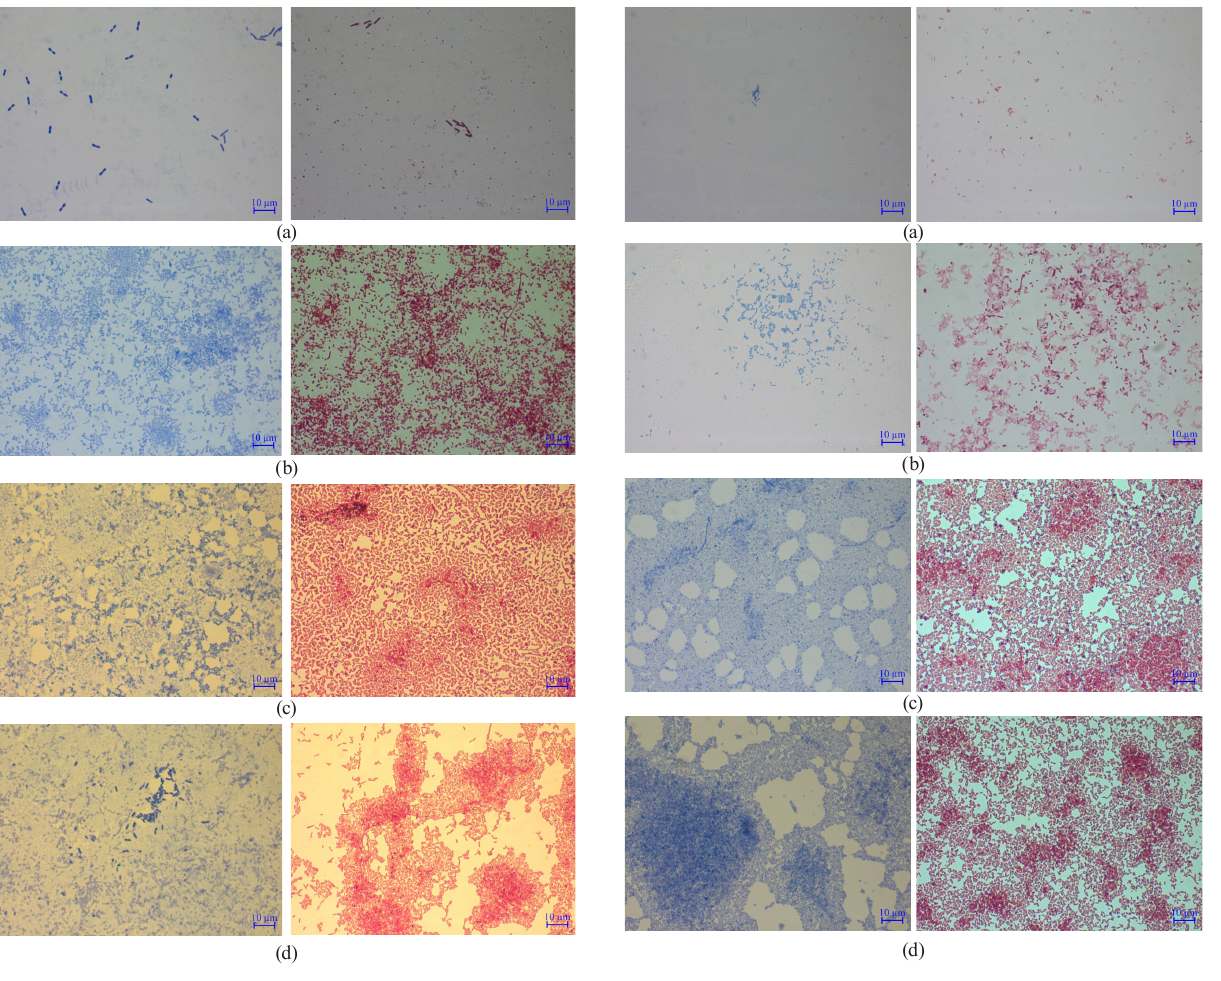
Figure 2 Micrographs of biofilms formed in skimmed milk permeate in: (a) 8 h, (b) 24 h, (c) 48 h, and (d) 72 h. Methylene blue staining (left) and Gram-staining (right). Magnification